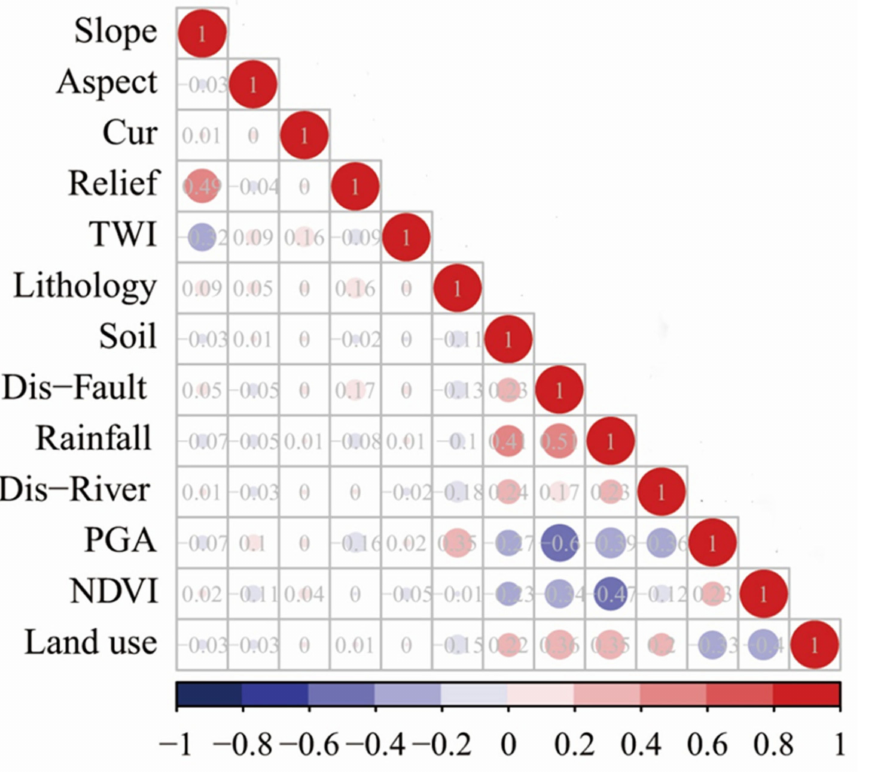
Figure 4. Pearson correlation values between